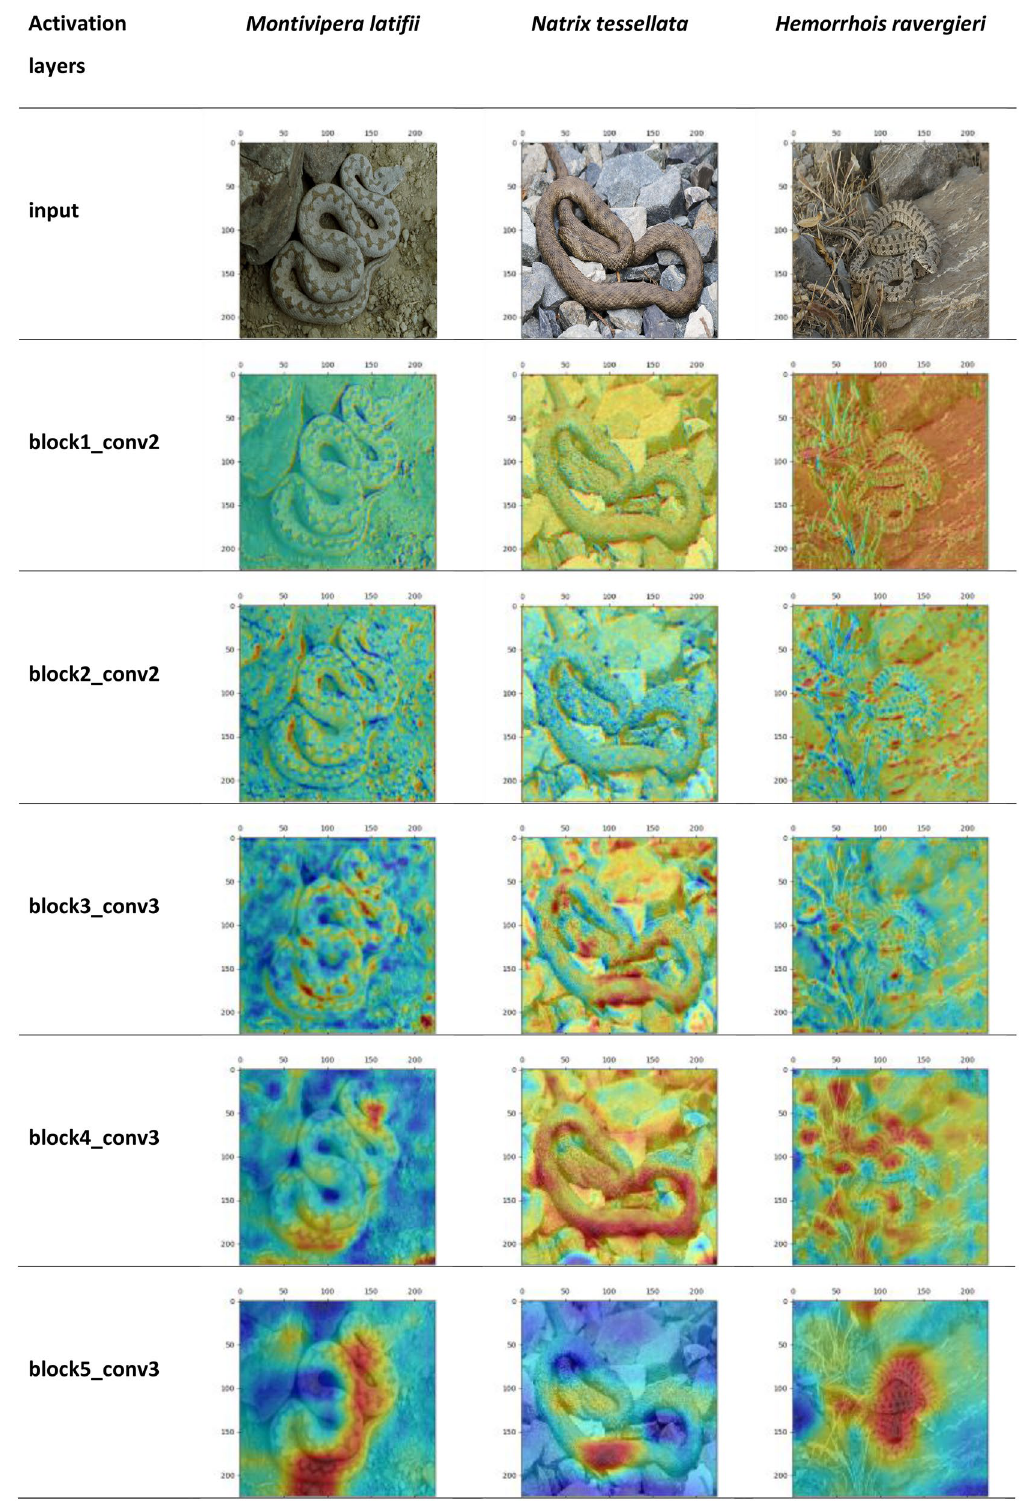
Figure 6. The heatmap visualization of discriminative regions within the hidden activation layers of VGG-16